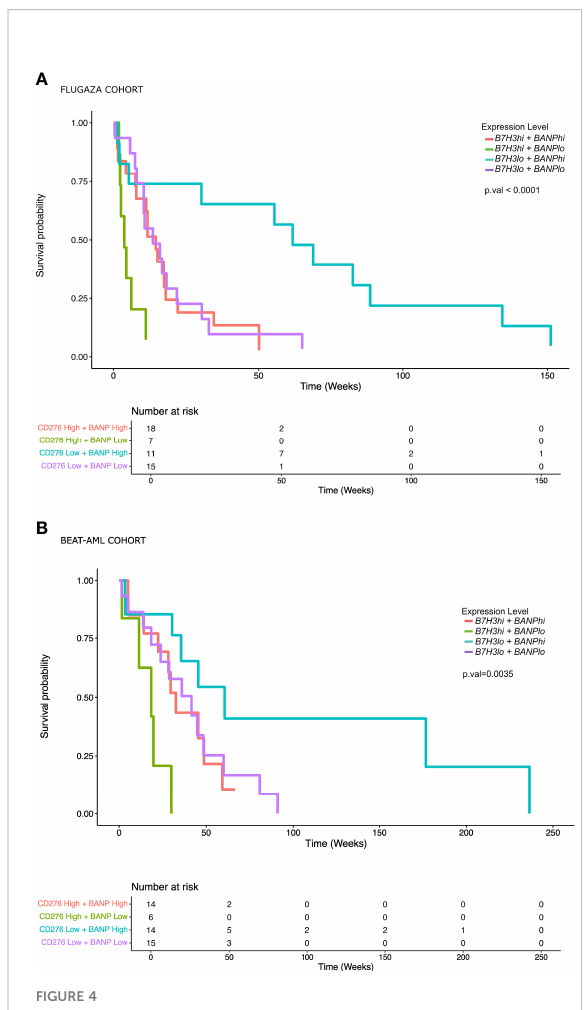
FIGURE 4 AML patients with low expression of B7H3 and high expression of BANP show a signi fi cantly better overall survival. (A) Overall survival analysis in AML patients with TP53 mutated or complex karyotype included in the PETHEMA-FLUGAZA trial using the expression of B7H3 and BANP genes. (B) Overall survival analysis in AML patients included in BeatAML cohort using the expression of B7H3 and BANP